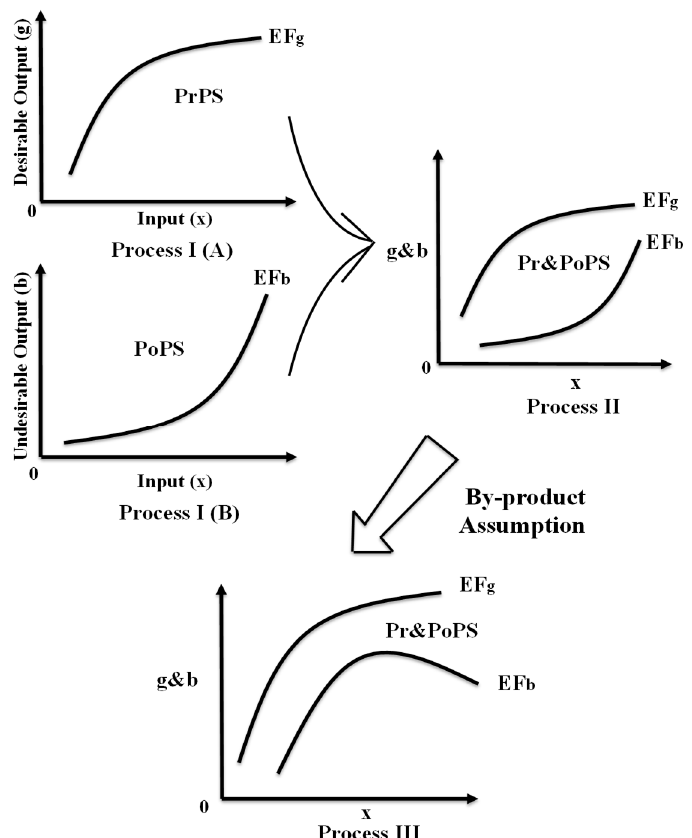
Figure 1. Unification between two groups of outputs. EF indicates an efficiency frontier. (a) The g and b stand for two different outputs. PrPS indicates a production possibility set, PoPS indicates a pollution possibility set. (b) Pr&PoPS indicate a production and pollution possibility set. (c) The last process (III) is for final unification by assuming that b is the by-product of g . This study considers the assumption under managerial disposability.